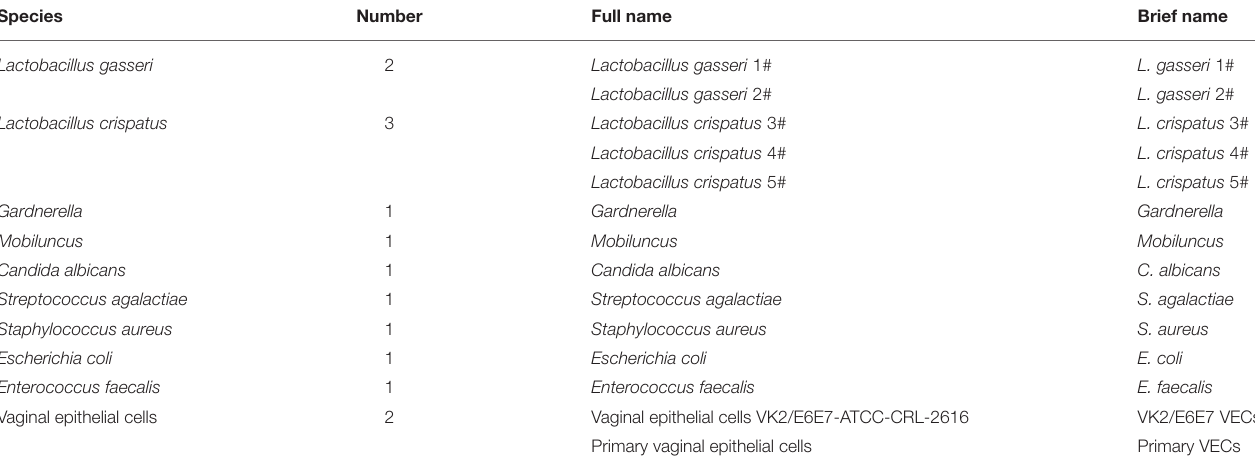
TABLE 1 | The species, number, full name, and abbreviated name of the bacteria and vaginal epithelial cells used in this study.